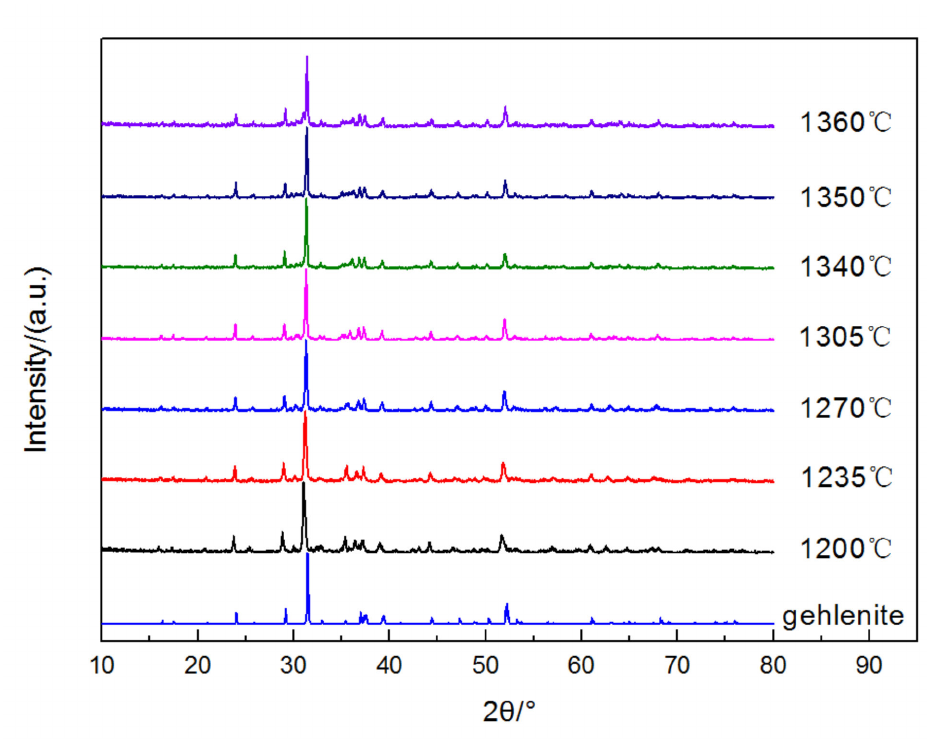
Figure 5. XRD patterns of steel slag with Al 2 O 3 –SiO 2 system sintering at different